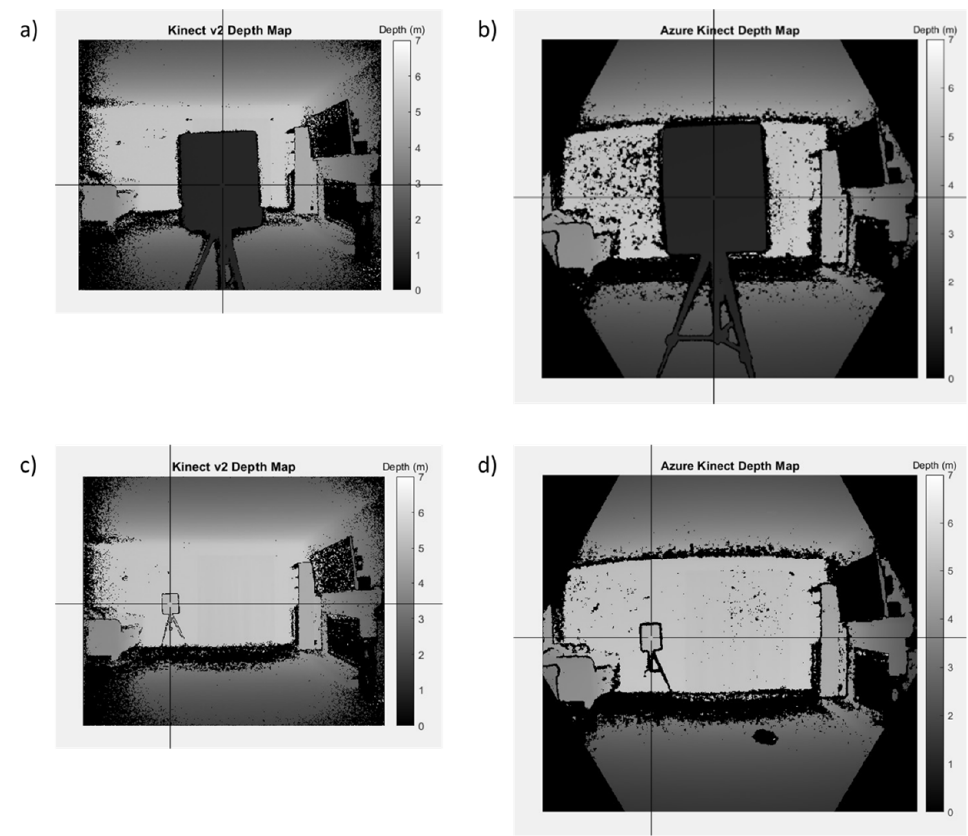
Figure 6. Pixel selection for computing the random depth error of the ( a ) Kinect v2 for board location 1, ( b ) Azure Kinect for board location 1, ( c ) Kinect v2 for board location 15, and ( d ) Azure Kinect for board location 15. Note that the depth maps are mirrored.